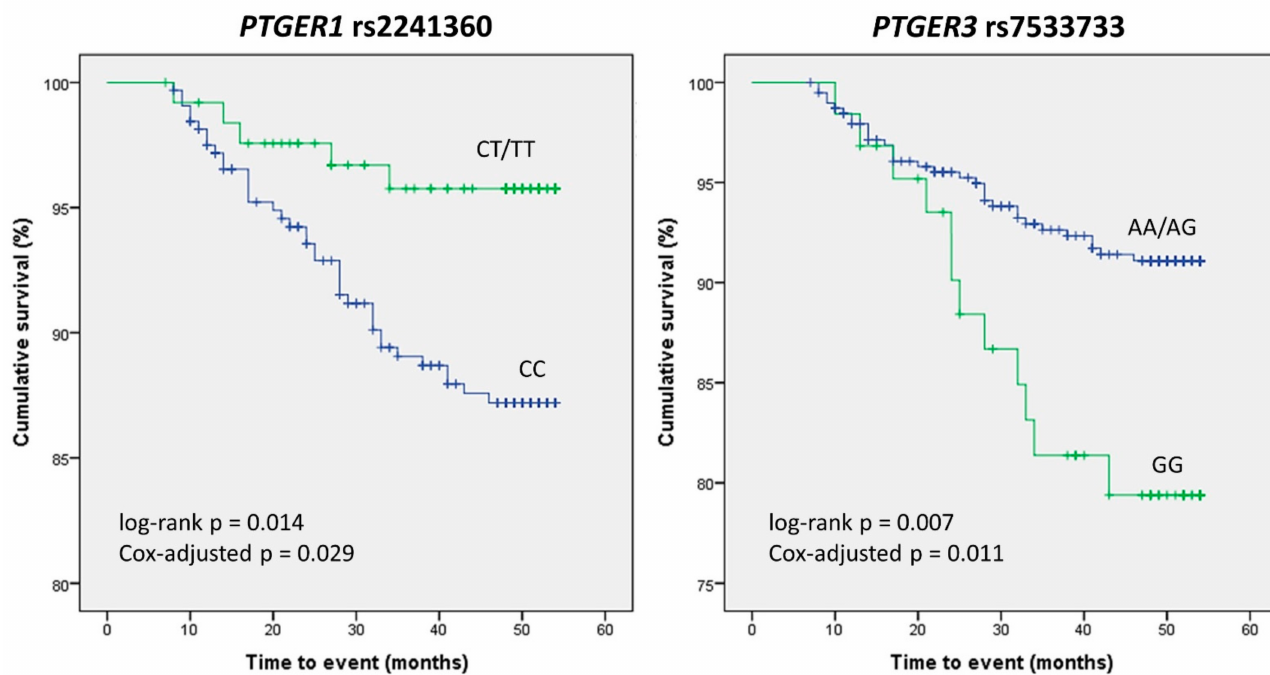
Figure 3. Kaplan–Meier curves depicting the occurrence of cardiovascular events in nephrosclerosis patients. Differences between genotypes of PTGER1 rs2241360 and PTGER3 rs7533733 are